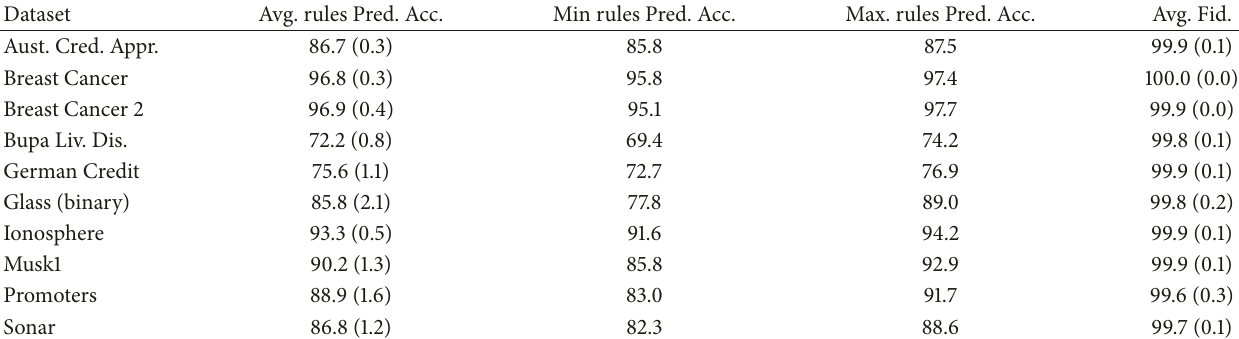
Table 14: Average predictive accuracy and average fidelity of rulesets by aggregating five